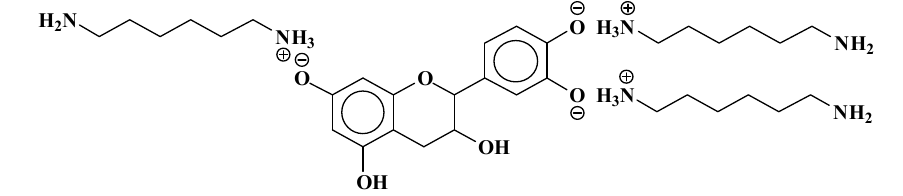
Figure 7. Example of covalent bonds dimer structure at 664 Da.